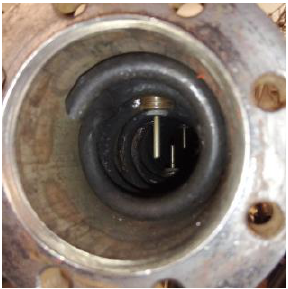
Figure 12. The internal view on the tube section with a Shchelkin spiral and ion sensors mounted between spiral